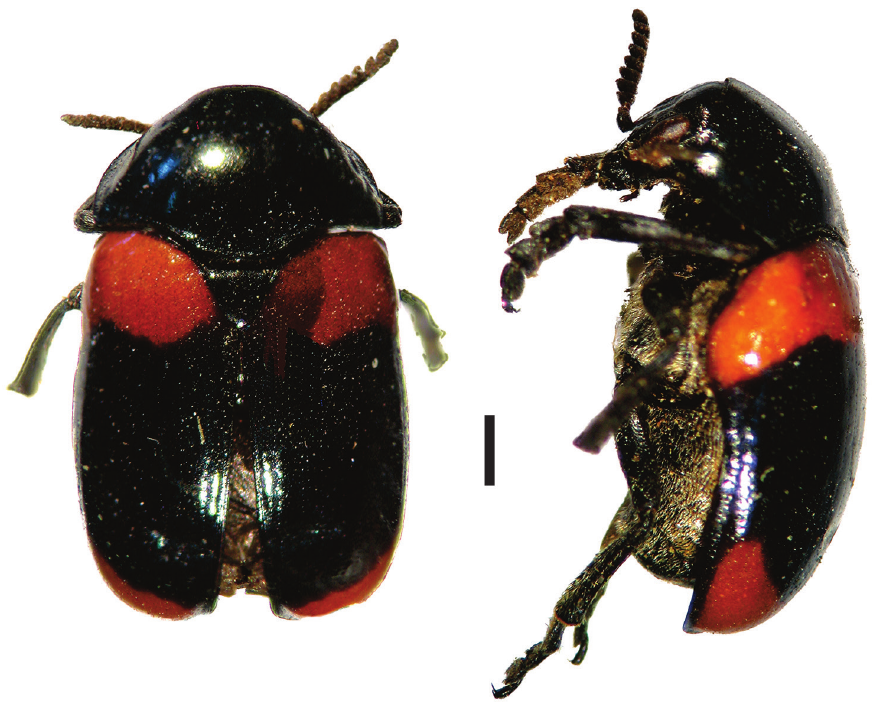
Figure 12. Stereoma clitellata clitellata Lacordaire (1) , left: habitus (dorsal view), right: habitus (lateral